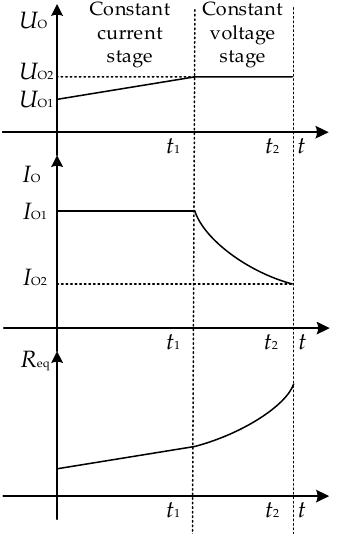
Figure 2. Charging characteristic curve of battery.